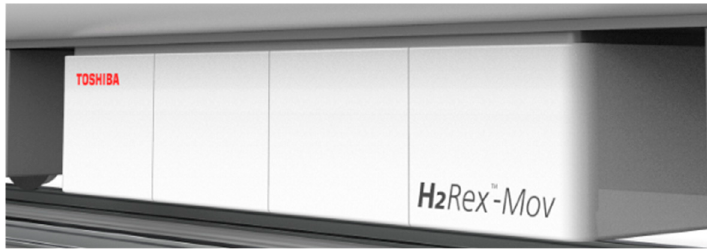
Figure 25. The marine hydrogen fuel cell “H2Rex™-Mov” [126].